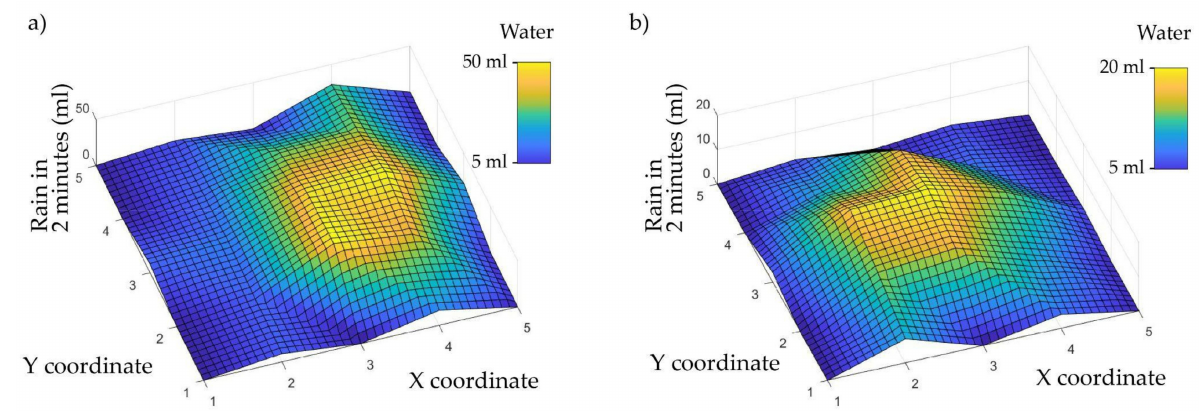
Figure 8. Rainfall intensity distribution under the ( a ) wooden and ( b ) aluminum structure simulator whose highest intensities mark the area to place the boxes with the